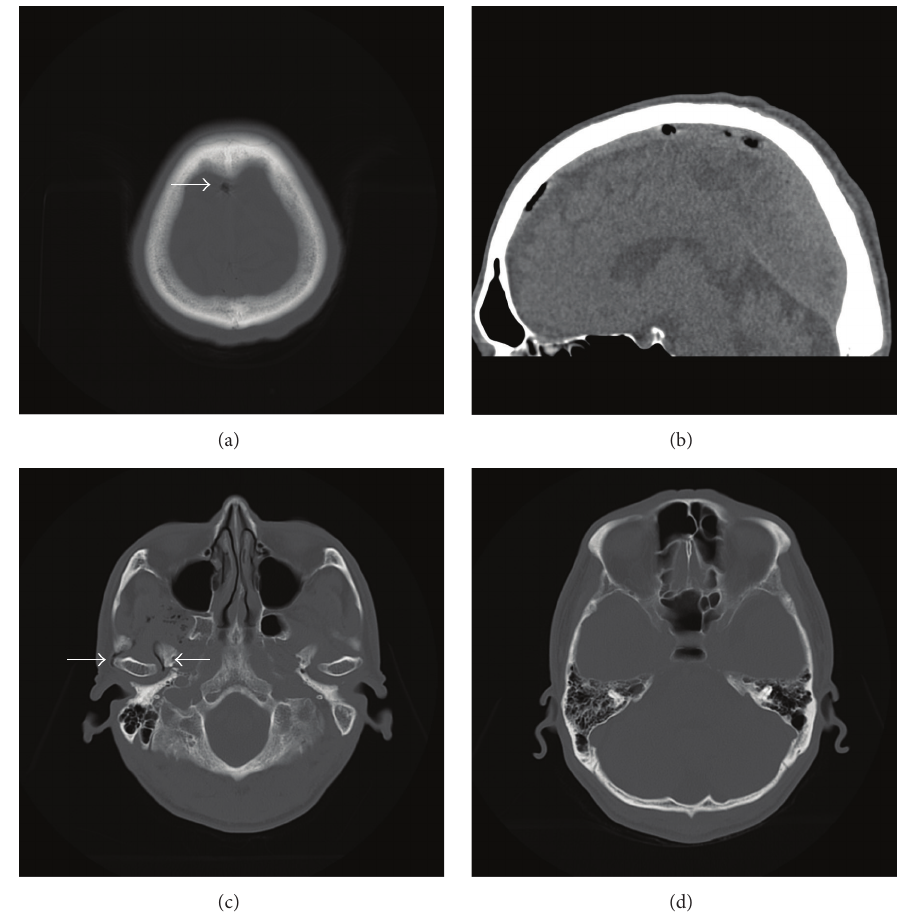
Figure 1: CT scan of the head without contrast: (a) axial cut (bone window) shows air in the superior sagittal sinus (arrow); (b) midsagittal cut of the reconstructed CT (brain window) shows air in the superior sagittal sinus; (c) axial cut (bone window) shows air around the right mandible (arrow); (d) axial cut (bone window) cannot show obvious fractures.